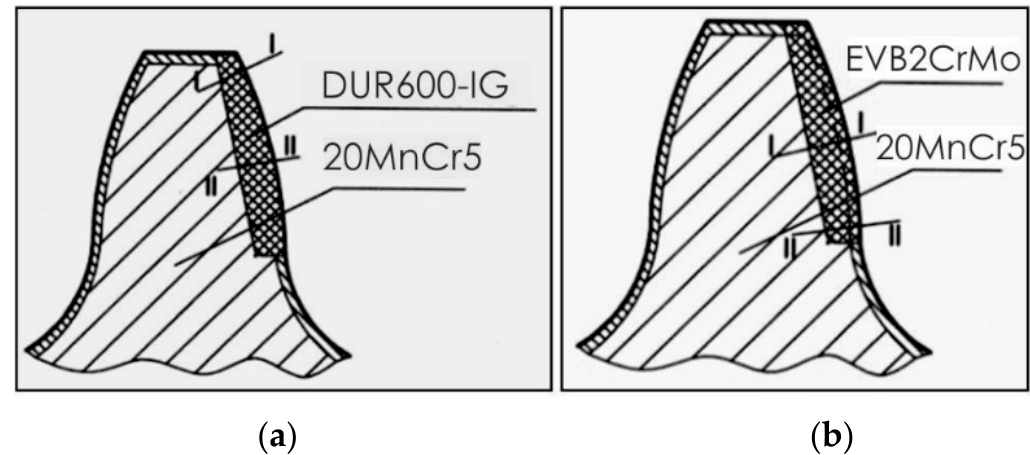
Figure 6. Microhardness measurements’ directions: tooth hard-faced with the DUR 600-IG FM ( a ) and tooth hard-faced with the EVB2CrMo FM ( b ). Table 3. Microhardness of tooth hard-faced with the DUR 600-IG FM—direction I-I. Hard-Faced Layer Joint Heat-Affected Zone (HAZ)